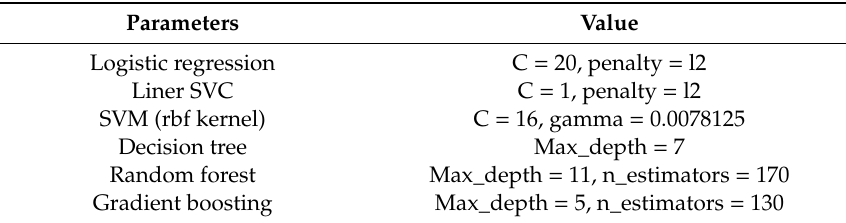
Table 3. Parameters in the machine learning model.